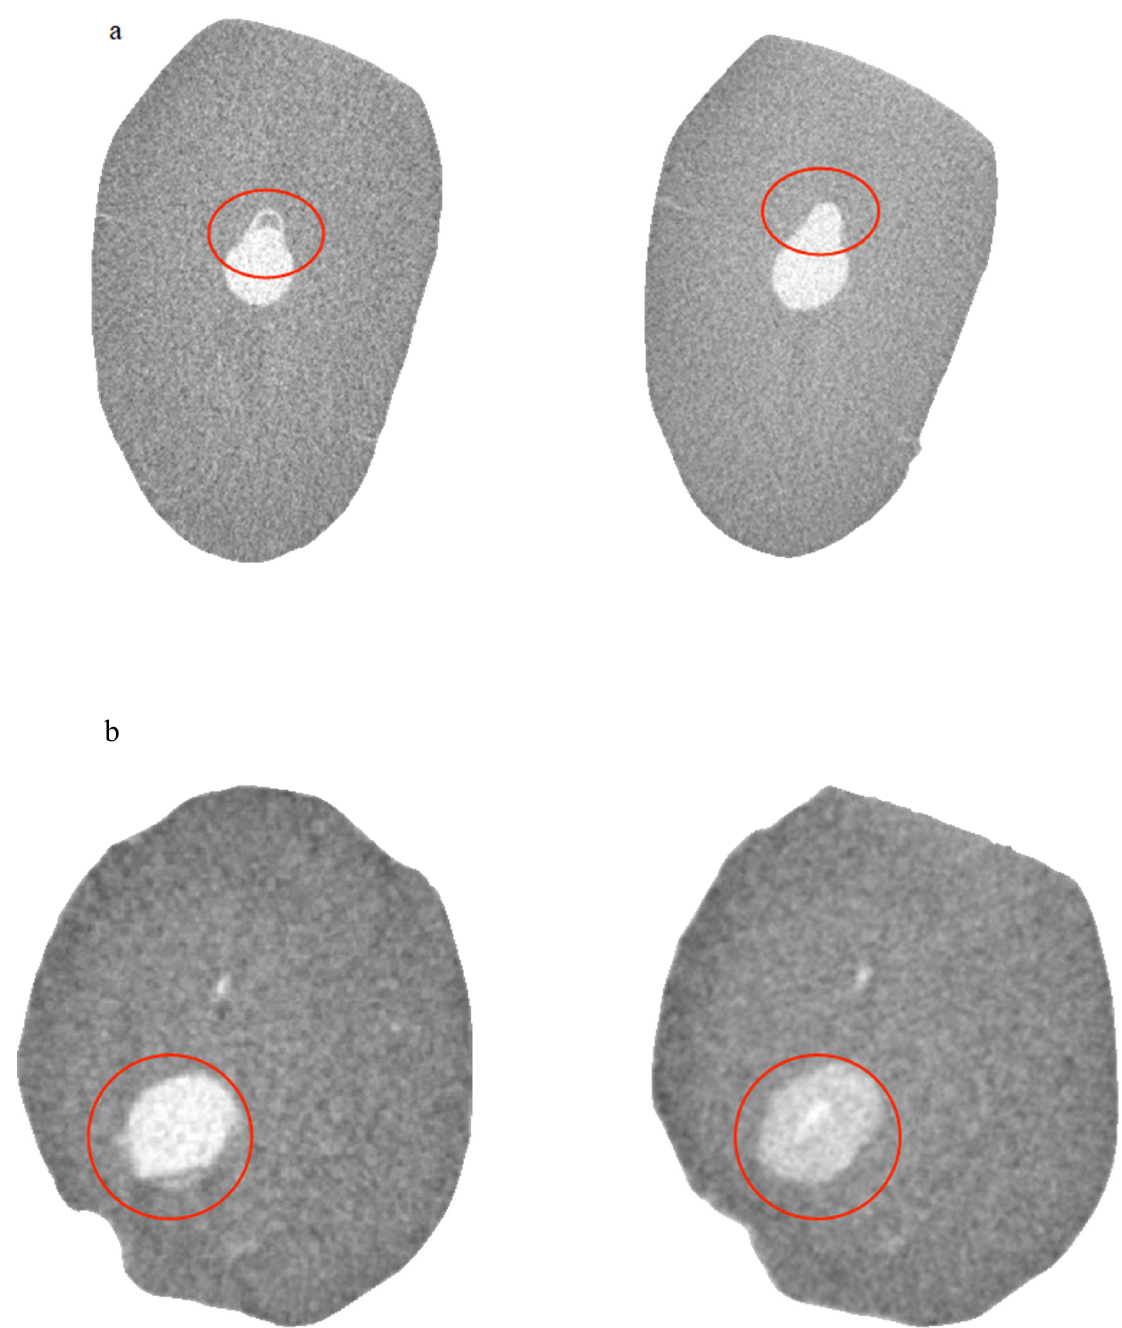
Figure 2. EA group—slice evaluation of ATHD: ( a ) before (image left) and after (image right) activation at middle third; ( b ) before (image left) and after (image right) activation at apical third.